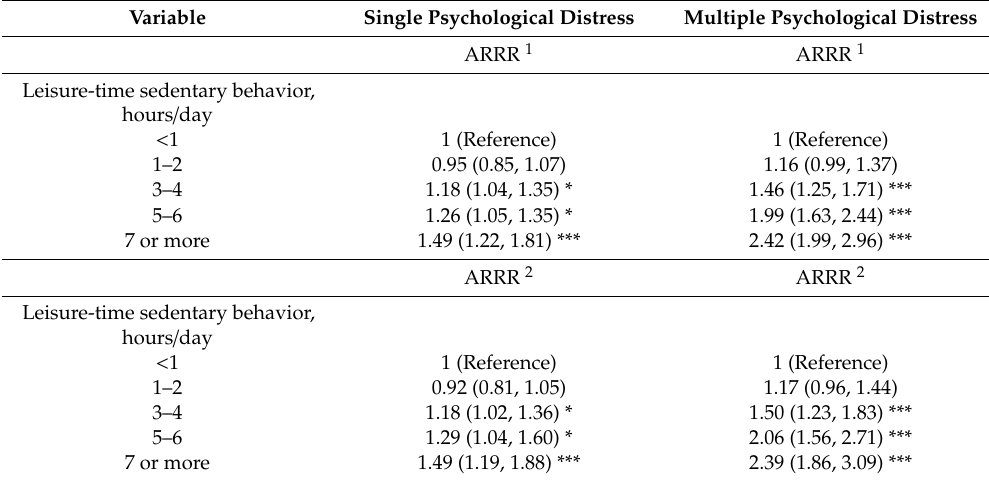
Table 3. Associations of leisure-time sedentary behavior with single and multiple psychological distress (with no psychological distress as reference category). Variable Single Psychological Distress Multiple Psychological Distress